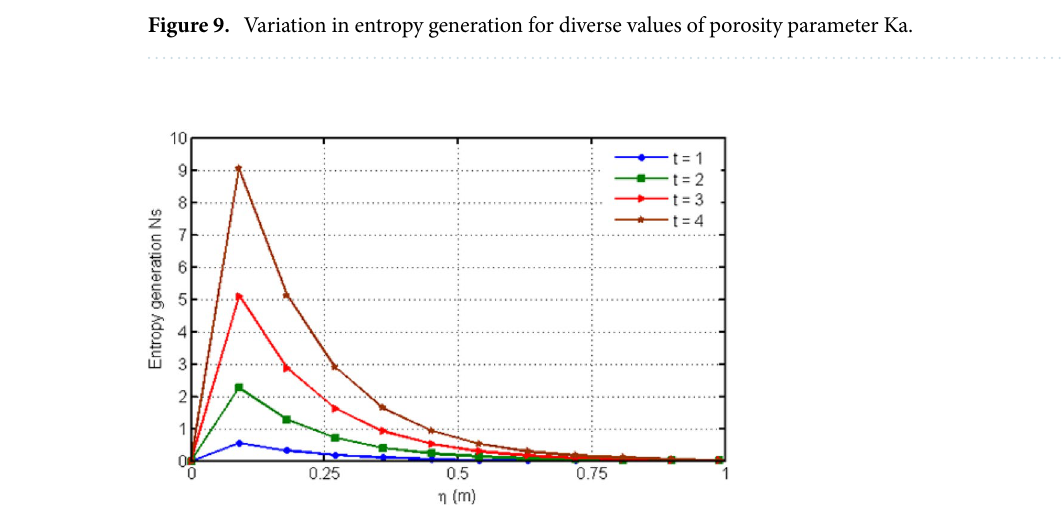
Figure 10. Variation in entropy generation for diverse values of time t